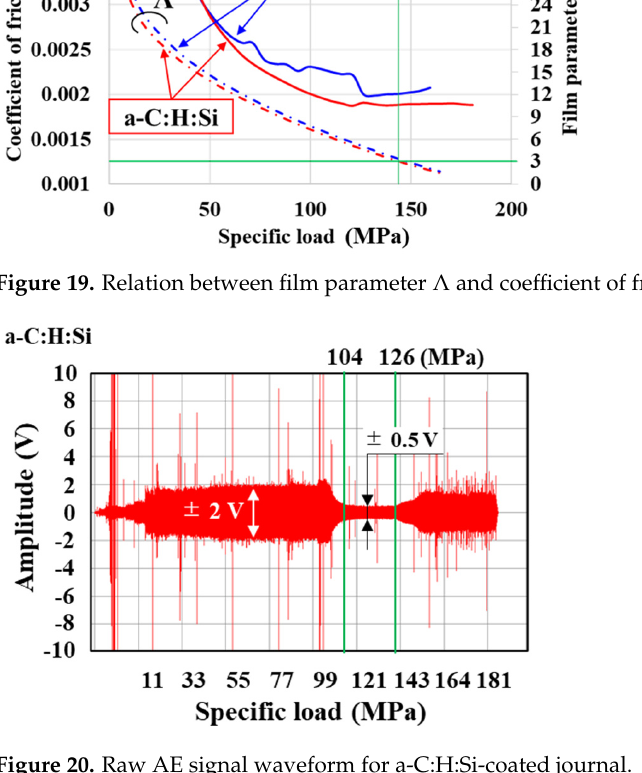
Figure 20. Raw AE signal waveform for a-C:H:Si-coated journal.